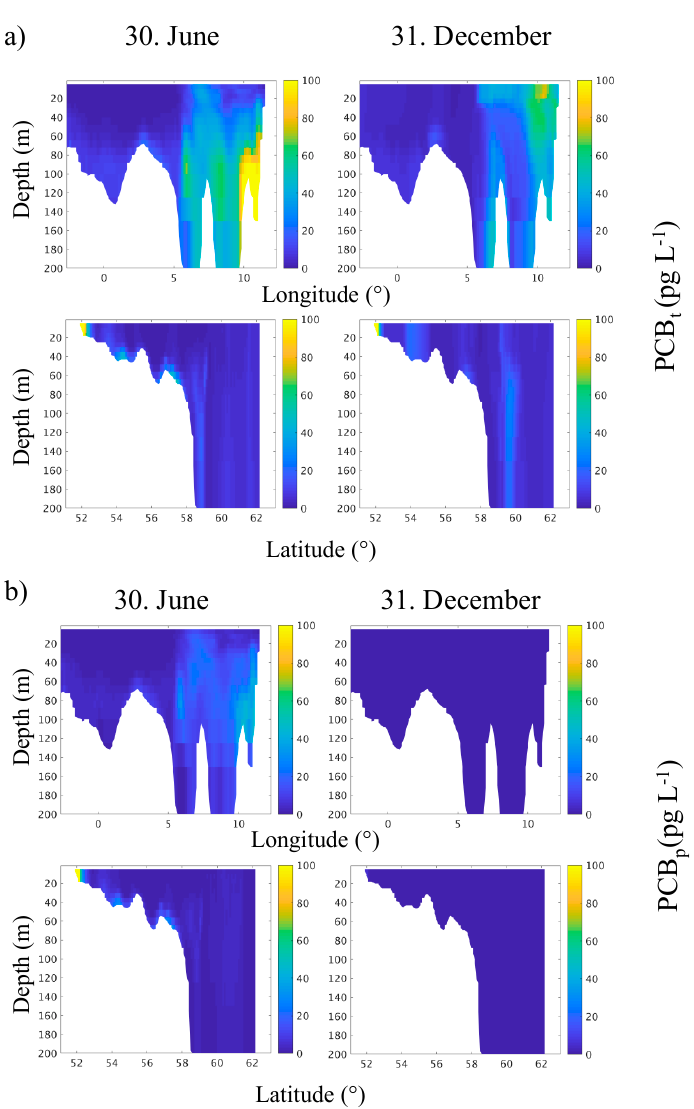
Figure 7. Vertical distributions of simulated total PCB (PCB t ) ( a ), and particulate PCB (PCB p ) ( b ) along transect 1 (upper panels) and transect 2 (lower panels) in June (left) and December (right).